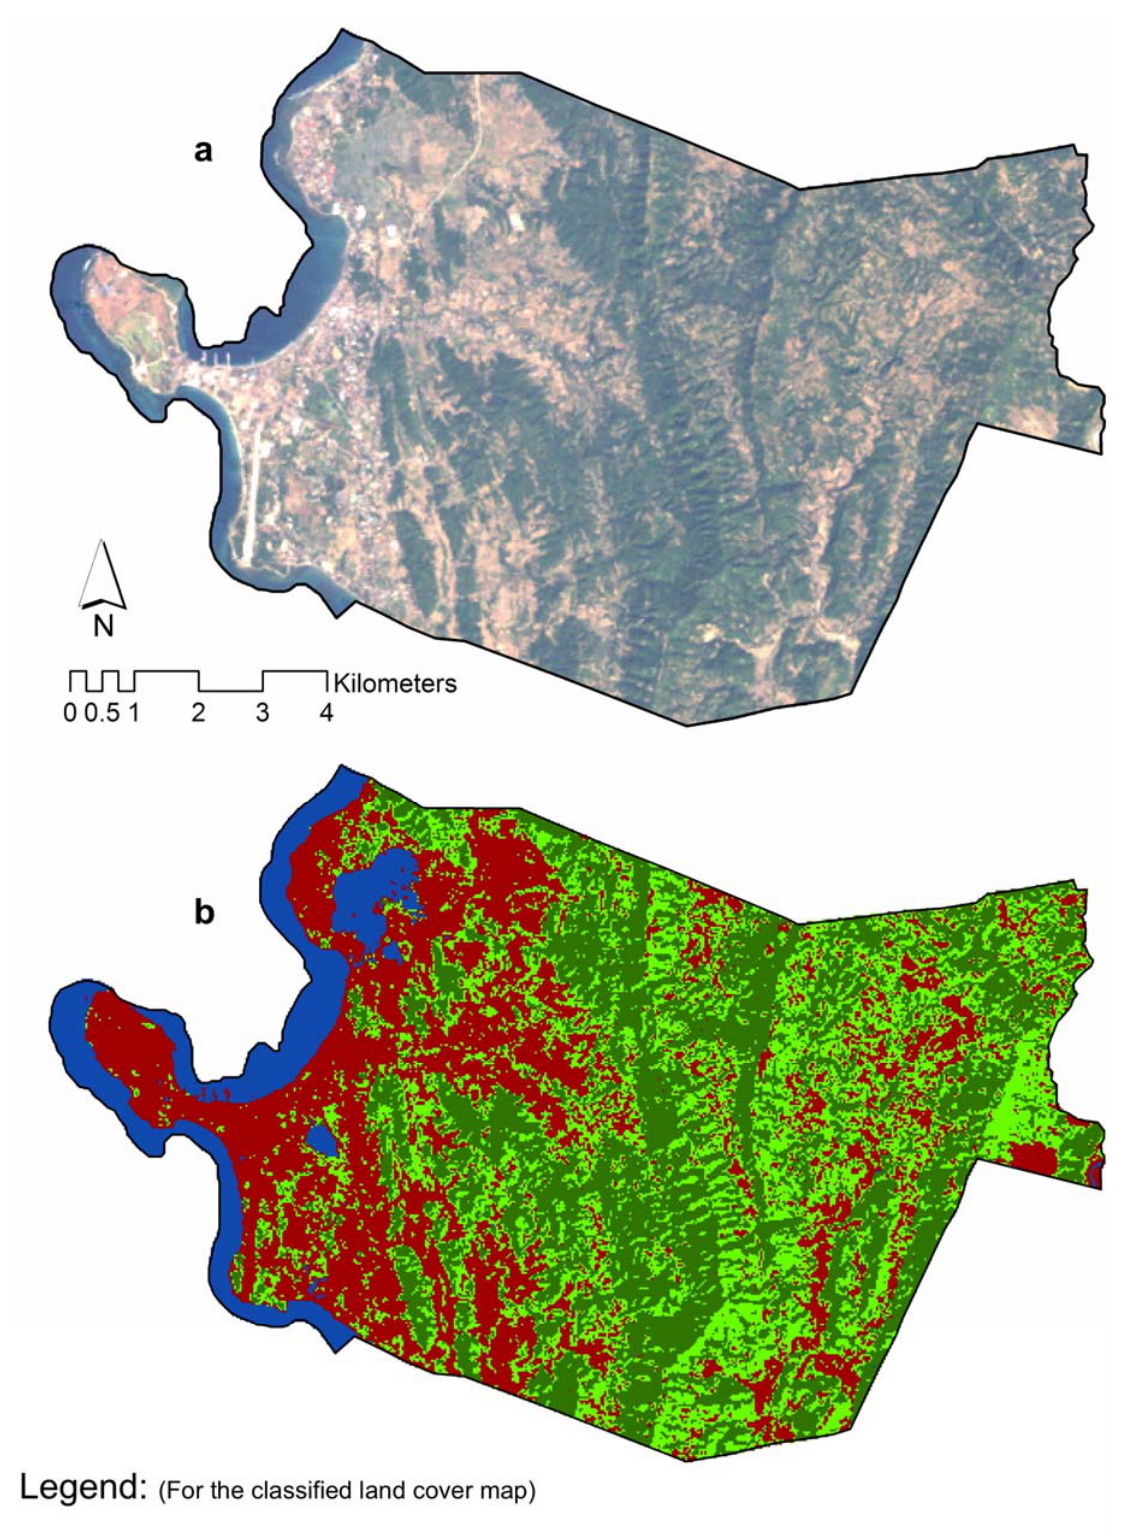
Figure 5. ( a ) The 2009 Landsat image displayed in its “true colour” composite (RGB:321). ( b ) The 2009 classified land cover map of the City of San Fernando, La Union, Philippines. Note: See Table 2 for the detailed descriptions of the land cover